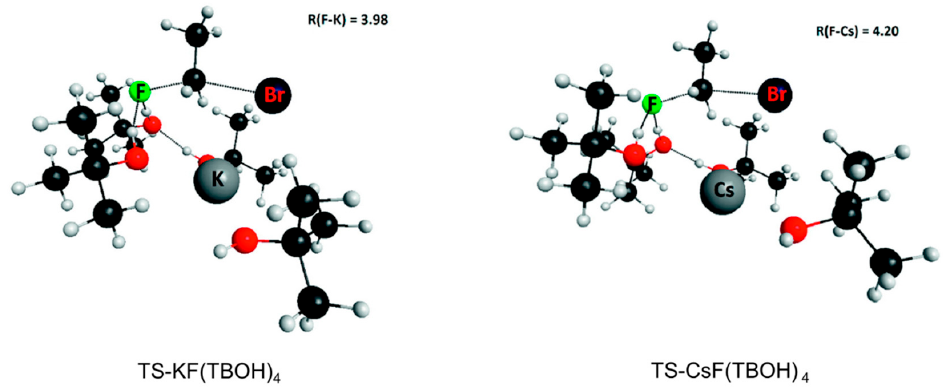
Figure 6. Cluster–continuum solvation of KF and CsF with four tert-butanol molecules.